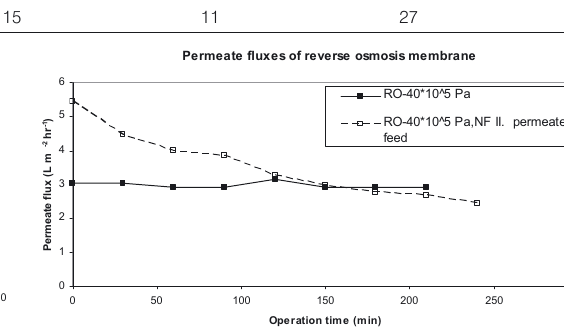
Figure 3. Permeate fluxes of reverse osmosis membrane vs. opera - tion time (wastewater of high